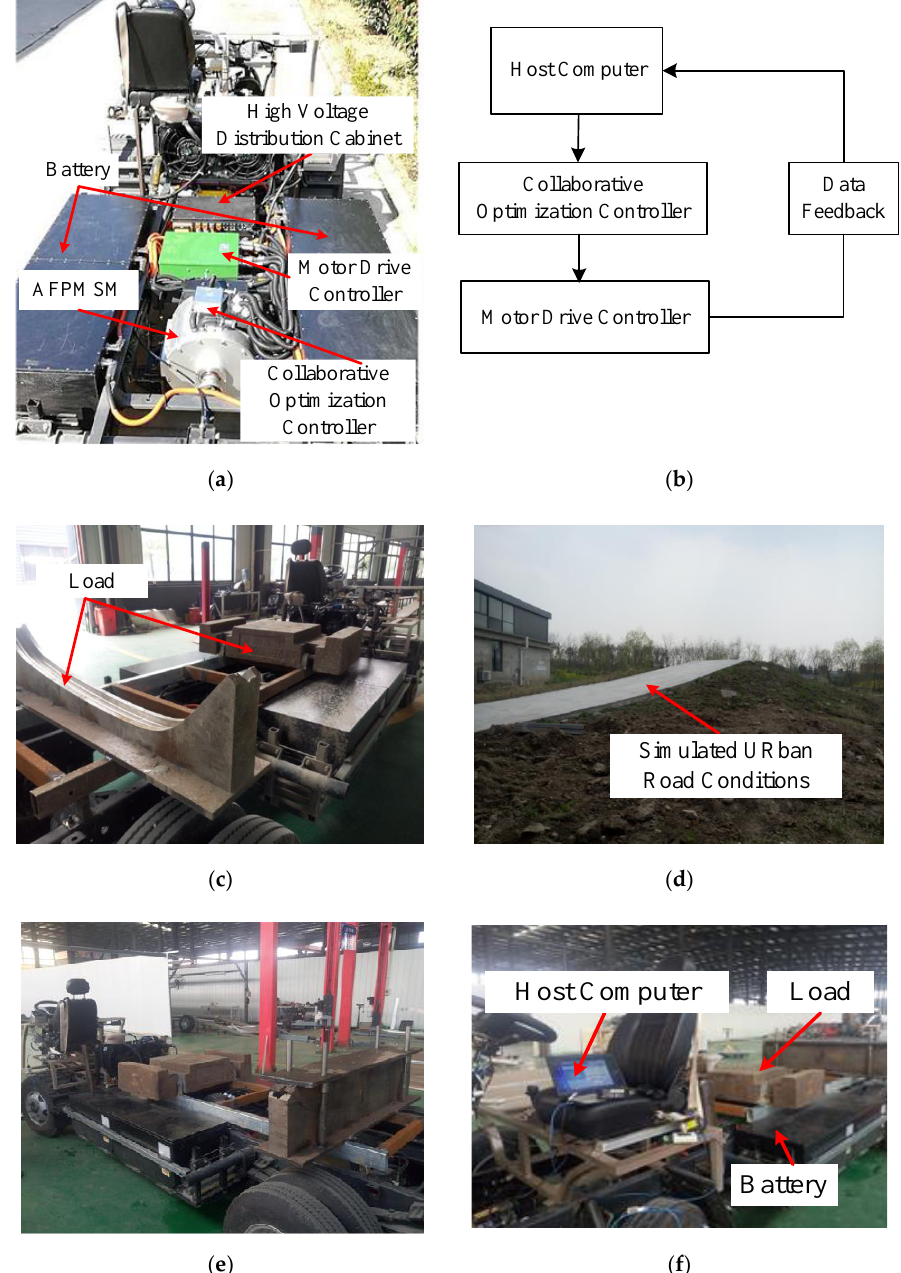
Figure 7. ( a ) The internal structure of the electric logistics vehicle; ( b ) The experimental block diagram ( c ) The total look of the electric logistics vehicle; ( d ) The simulated urban road condition; ( e ) The experimental load; ( f ) The experimental upper computer.